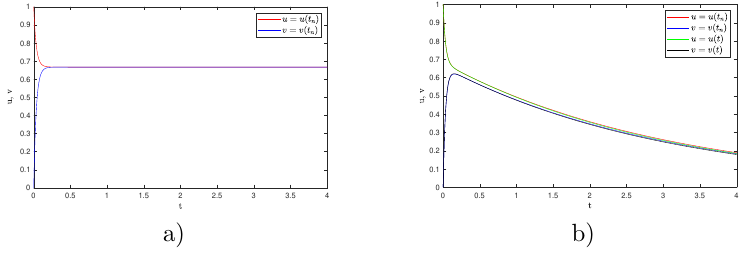
Figure 1. Solutions of the initial value problem (6.1): a) γ = 0, b) γ = 1.